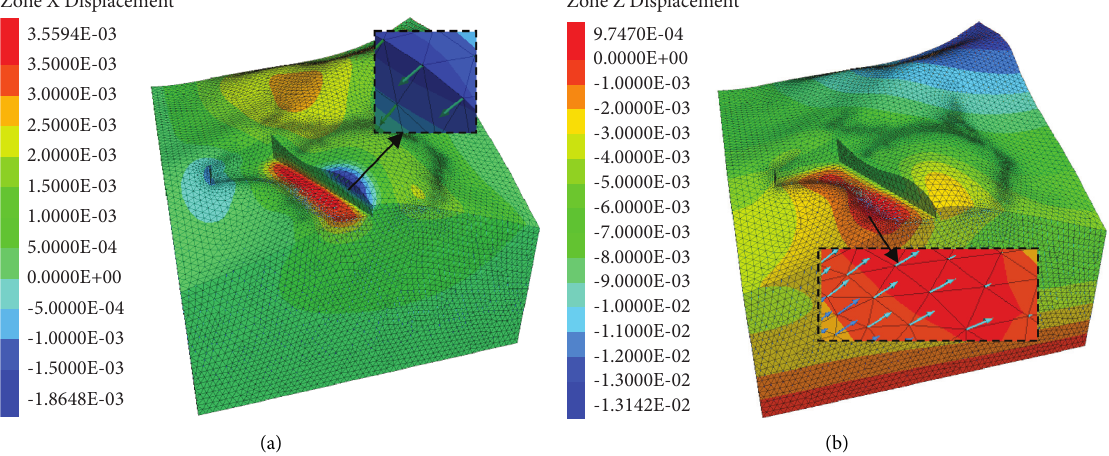
Figure 8: Strain nephogram after first excavation. (a) X -direction strain nephogram and (b) Z -direction strain nephogram.